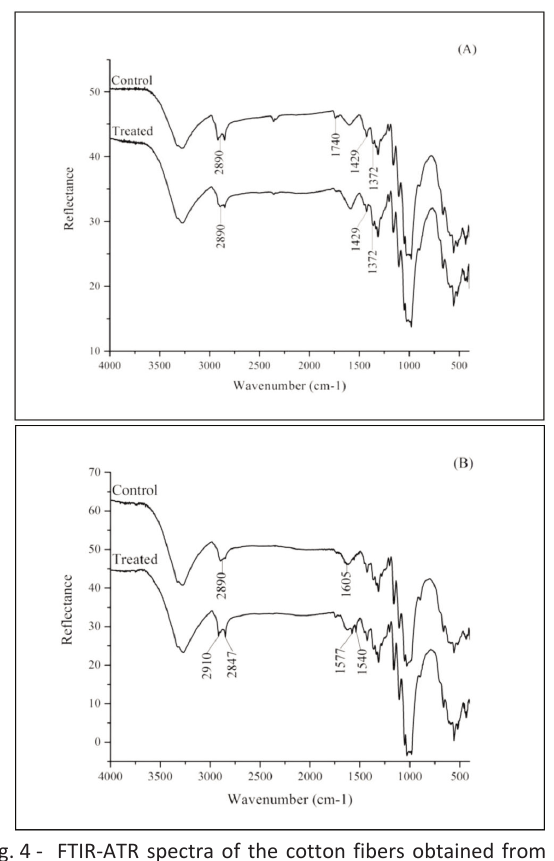
Fig. 4 - FTIR-ATR spectra of the cotton fibers obtained from (A) ‘Aleppo 118’ control and treated plants and (B) ‘Deir Al- Zour 22’ control and treated at room temperature in the range 400-4000 cm -1 . The recorded spectra were repea- ted three times and showed a typical and characteristic absorption bands for common cotton fibers substances.